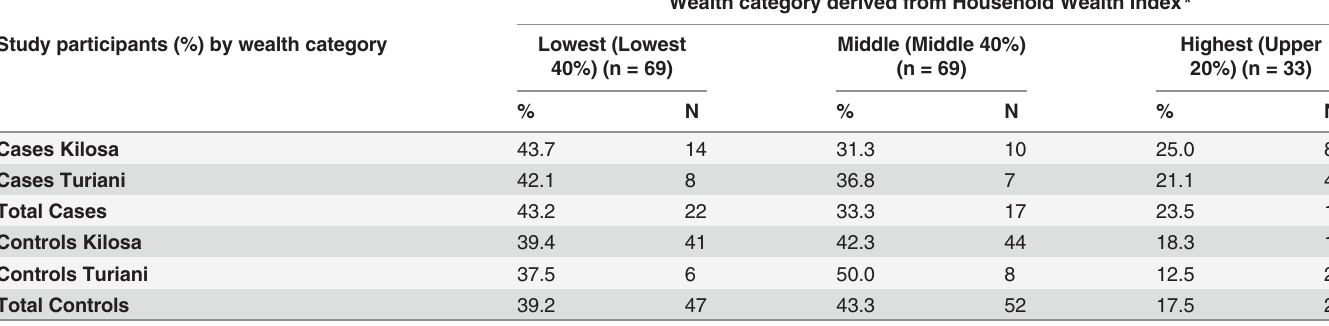
* Estimated using information on household possessions (table, radio, lantern, bicycle and iron) and food problems.